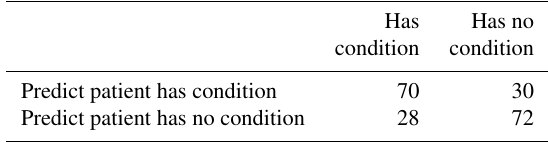
Table A2. A 2 × 2 contingency table for 200 patients undergoing a medical test for the presence or absence of a condition.